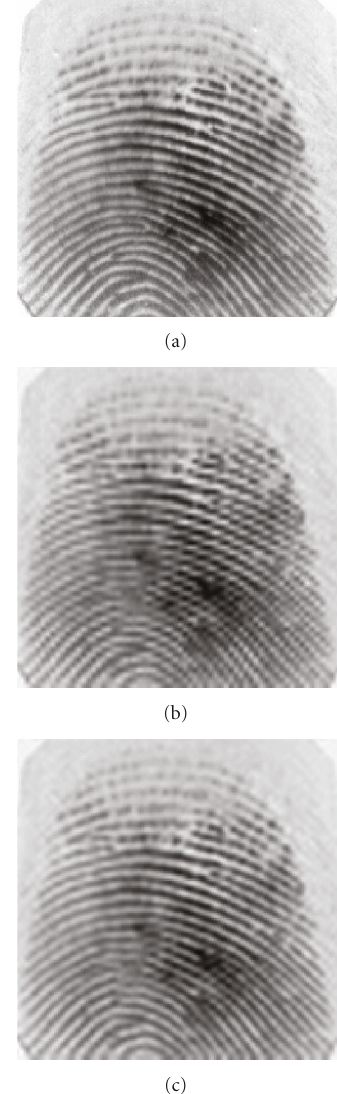
Figure 16: Transform performance. (a) Original fingerprint image; comparison of the performance obtained with (b) D9/7 fixed point implementation and (c) best evolved